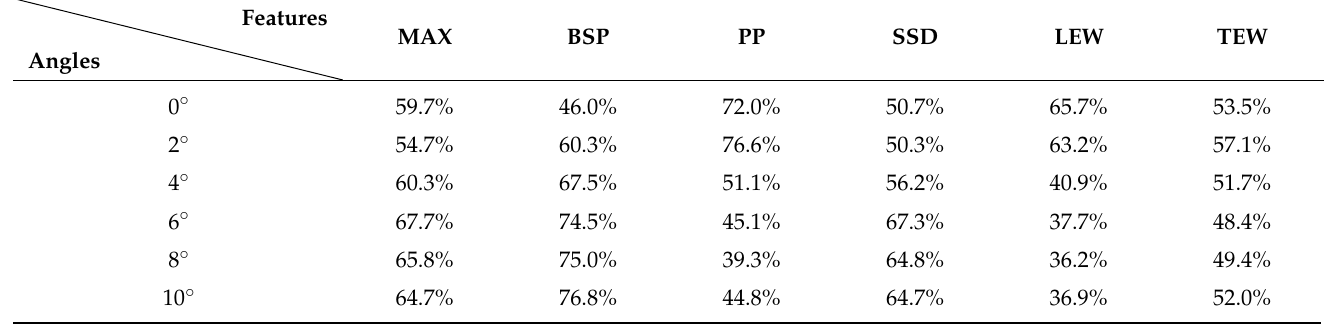
Table 5. Overall accuracies of waveform features at small incidence angles using a Gaussian